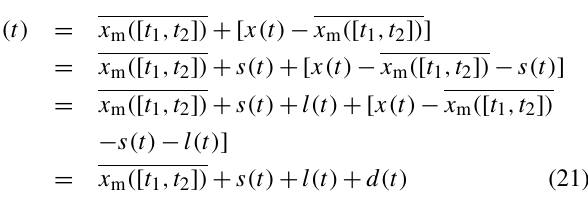
; and (d) and (h) for CH (cid:48) . A description of the CH ∗ and CH (cid:48) products is given 4 4 4 4